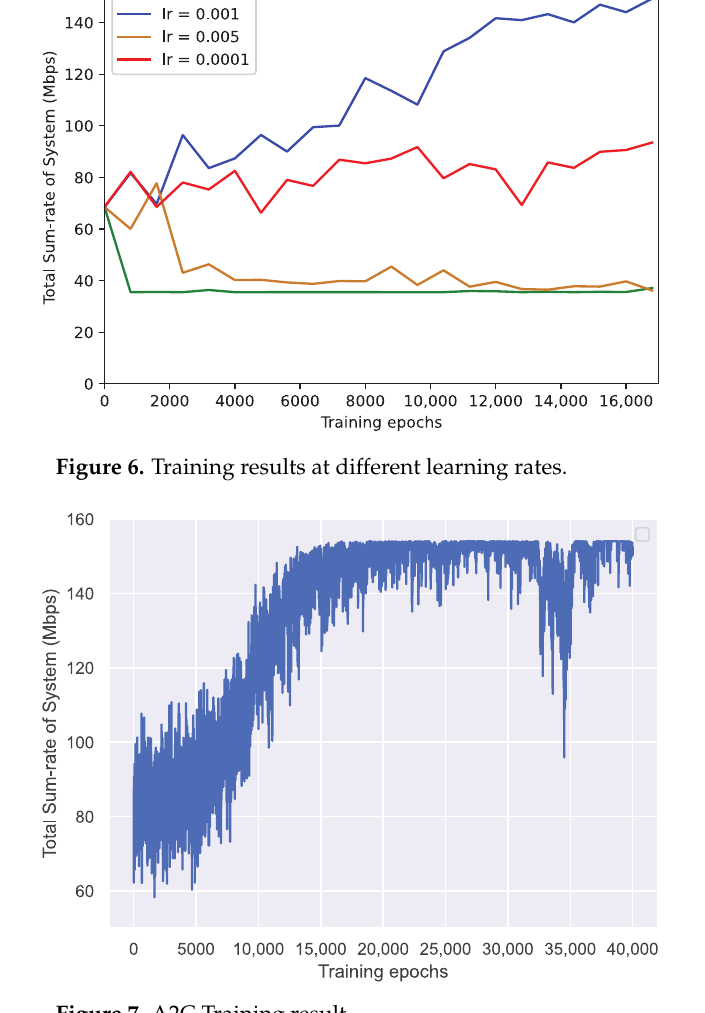
Figure 7. A2C Training